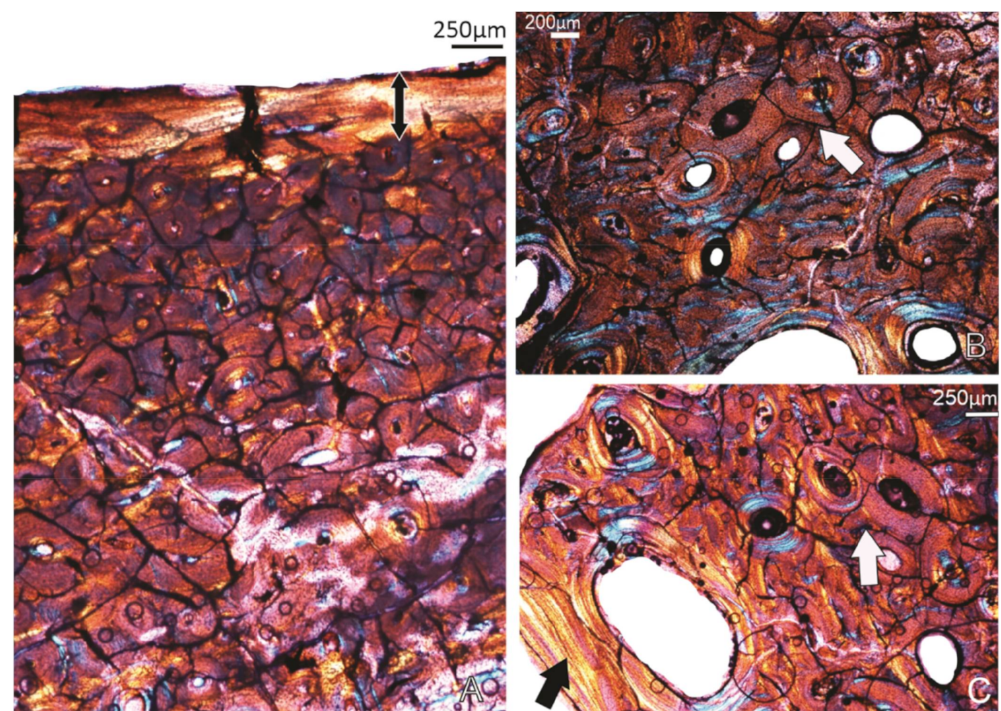
Figure 9. ( A – C ) Specimen SAM P.53832 TMT. ( A ) Except for the OCL (double-headed arrow), the compacta have been extensively reconstructed. ( B ) The dense development of secondary osteons (white arrow). ( C ) The perimedullary margin lined by an ICL (black